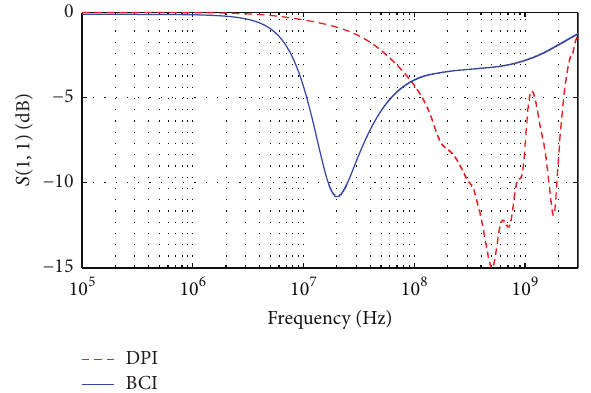
Figure 21: Comparison of DPI and BCI input reflection 𝑆(1, 1) with chip VDD/VSS port impedance